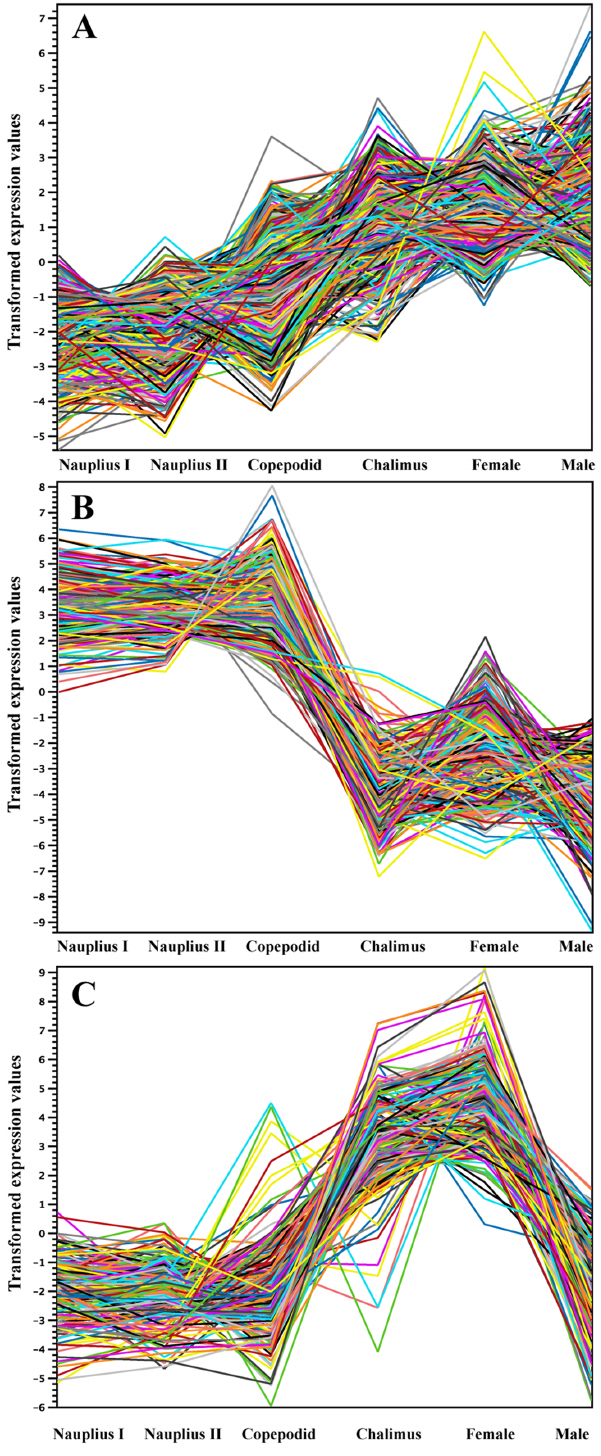
Figure 2. Gene expression profiles during larvae stages and adults of C. rogercresseyi generated by high-throughput transcriptome sequencing. (A) Overview of log 2 expression ratios of all transcripts differentially expressed from nauplius I, nauplius II, copepodid, chalimus, adult females and adult males. (B and C) Two patterns of expression were detected by K-means algorithm using transformed expression values.